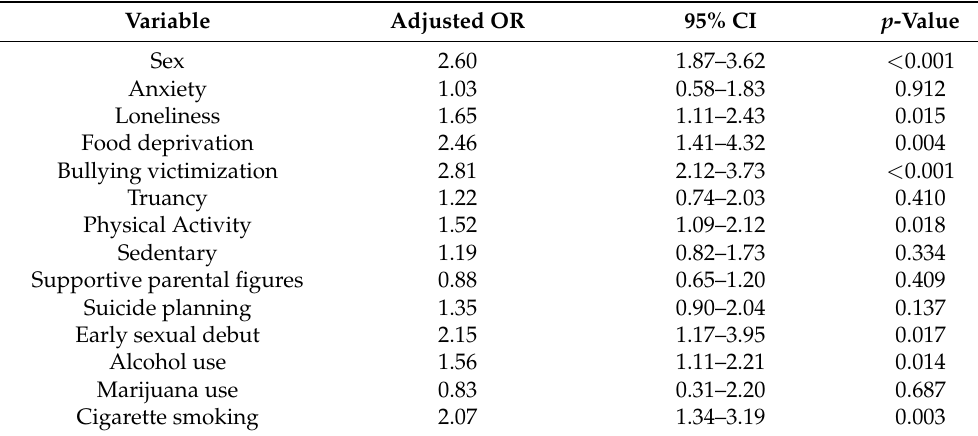
Table 4. Outcomes of multivariate analysis of variables associated with physical fighting among school-attending adolescents in Mauritius, GSHS